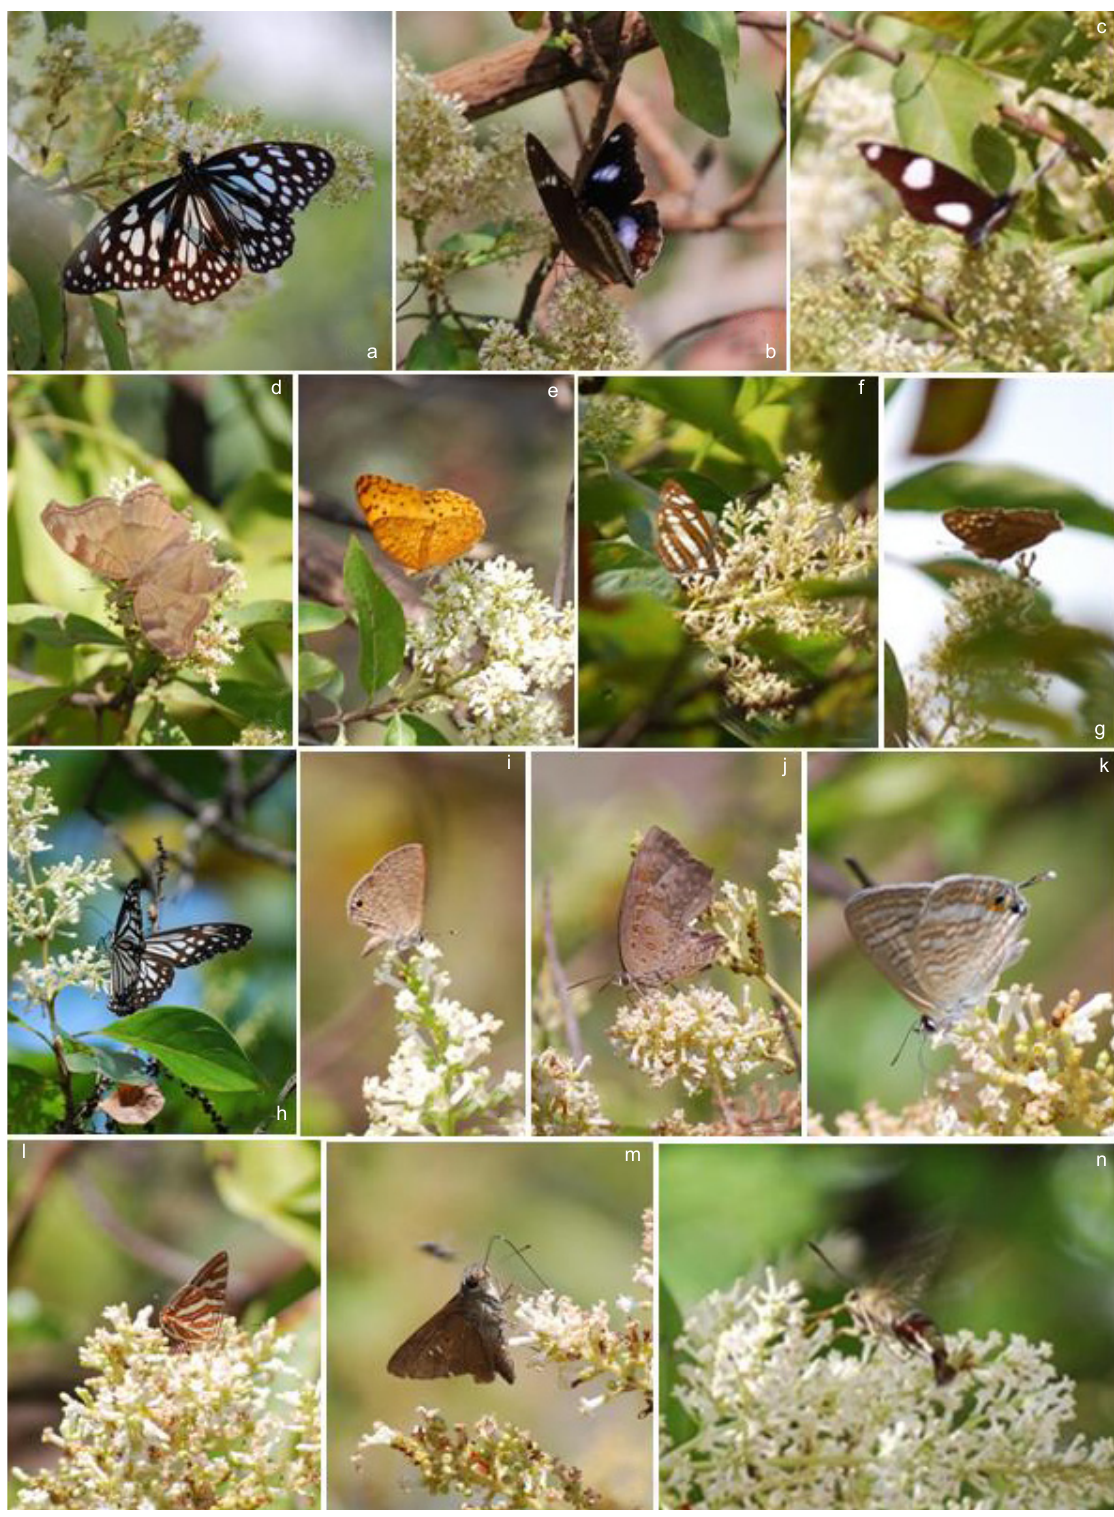
Image 2. Butterflies observed on Wendlandia tinctoria a - Tirumala limniace; b - Hypolimnas bolina; c - Hypolimnas misippus; d - Precis iphita; e - Phalanta phalantha; f - Neptis hylas; g - Junonia lemonias; h - Parantica aglea; i - Jamides celeno; j - Arhopala amantes; k - Lampides boeticus; l - Spindasis vulcanus; m - Borbo cinnara; n - Cephonodes